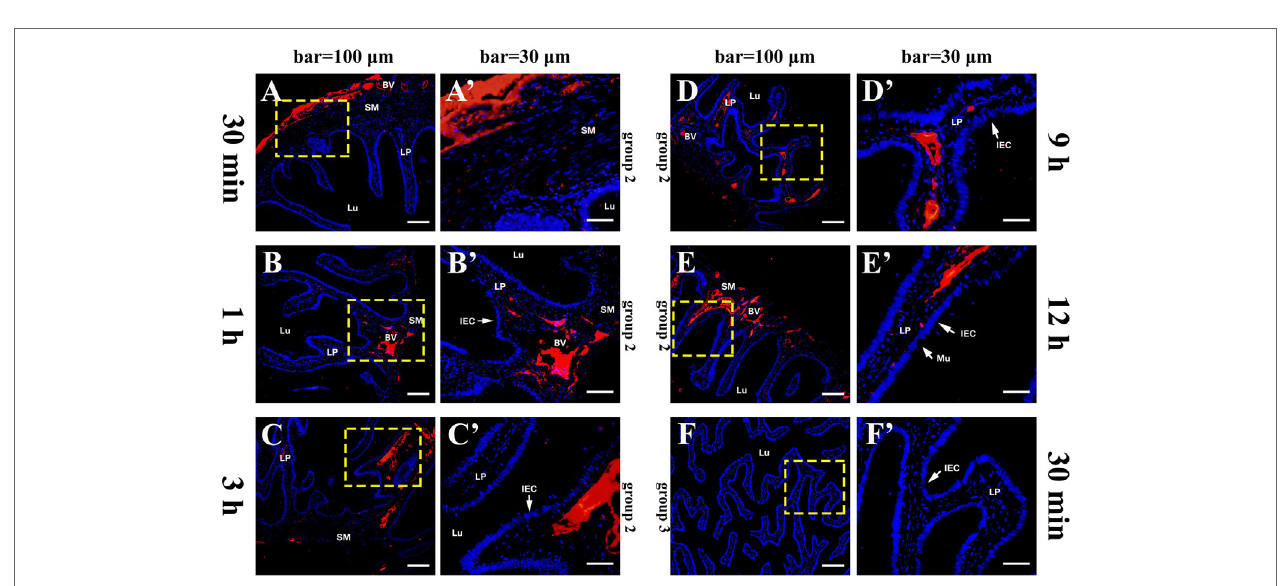
FigUre 3 | Tissue distribution of OVA in flounder hindgut of group 2 and group 3 by indirect immunofluorescence assay after challenge. (a–e) The distribution of OVA in group 2 at 30 min, 1 h, 3 h, 9 h, and 12 h after challenge, respectively, bar = 100 µm. Positive red fluoresce representing OVA was only detected in LP submucosa but not in the epithelial cells, and did not disappear at 12 h, showing that OVA could not be transported across epithelial cells from LP to lumen. (a ′ –e ′ ) The higher magnification view of the insert area (yellow box) in (a–e) , respectively, bar = 30 µm. (F,F ′ ) The results of group 3 at 30 min after challenge, showing no OVA-positive signals in the hindgut. Abbreviations: LP, lamina propria; Lu, lumen; IECs, intestinal epithelial cells; Mu, mucus cells; BV, blood vessel; OVA, ovalbumin.